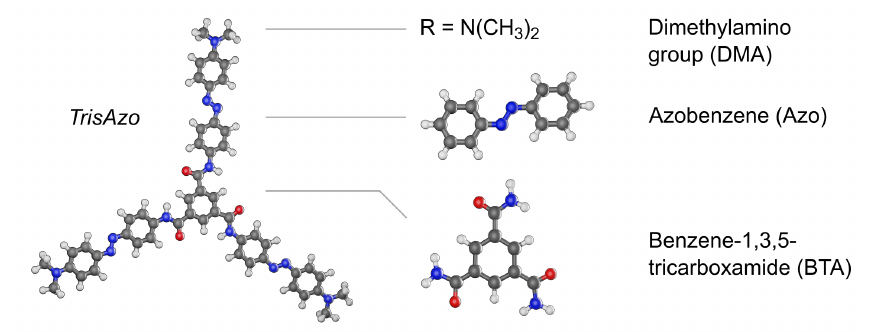
Figure 1. The star-shaped multiphotochromic molecule TrisAzo and its constituents. The compound consists of three azobenzene (Azo) groups, each para-substituted with a dimethylamino (DMA) group, and linked at the center by